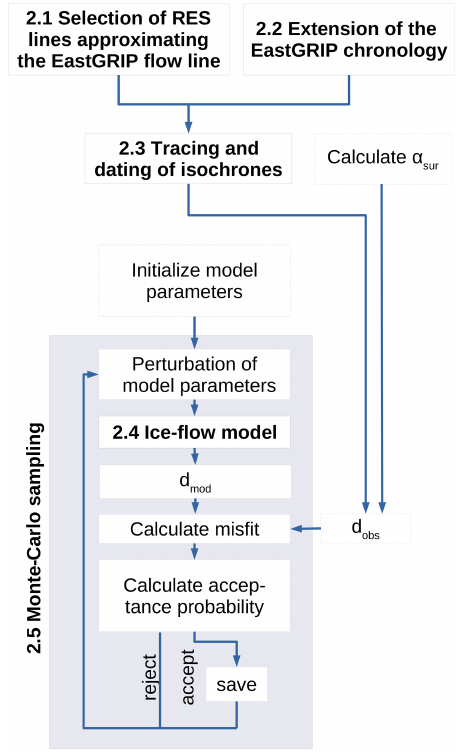
Figure 2. Workflow of the applied steps leading to the results de- scribed in Sect. 3. The main steps are described in Sect. 2.1–2.5 and marked with the corresponding numbers in the figure: the observed data ( d obs ) constraining the Monte Carlo method consist of the α sur calculated from the ice surface velocities and the isochrone depths along the flow lines. The latter is obtained by approximating the EastGRIP flow line with selected RES images (Sect. 2.1), extend- ing the EastGRIP chronology to the current drill depth (Sect. 2.2), and subsequent tracing and dating of isochrones (Sect. 2.3). The it- erative Monte Carlo sampling process is illustrated in the grey box (Sect. 2.5) and includes data simulation by a Dansgaard–Johnsen ice-flow model described in Sect.